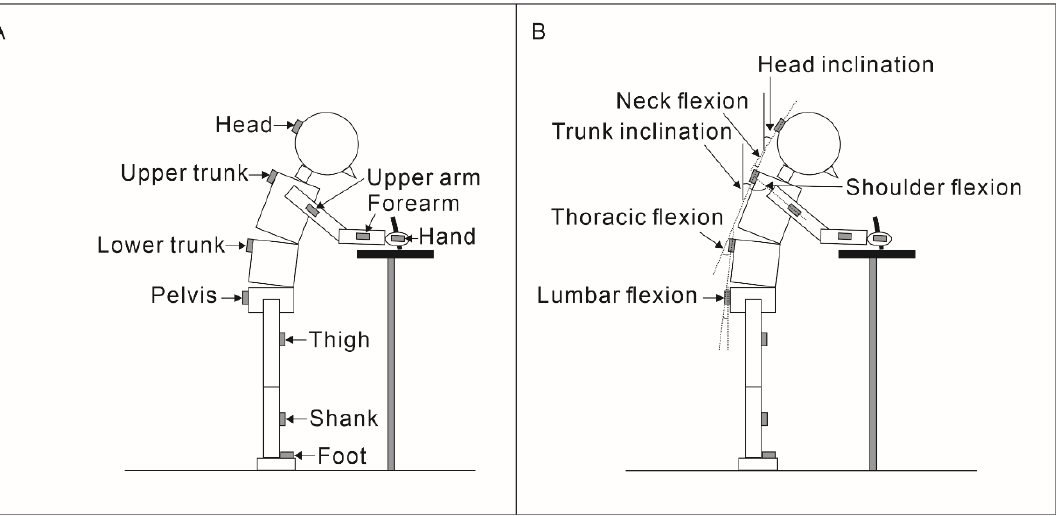
Figure 2. Experimental setup of inertial measurement unit (IMU) data. Sixteen IMU sensors were attached to standardized locations on the head, upper trunk, lower trunk, pelvis, both upper arms, forearms, thighs, shanks, and feet ( A ). Segment angles were measured using the sagittal inclination of each sensor (dashed lines) relative to the global reference (solid lines; B ), while joint angles were measured using the sagittal inclination of each sensor relative to another sensor (dashed lines; B ).